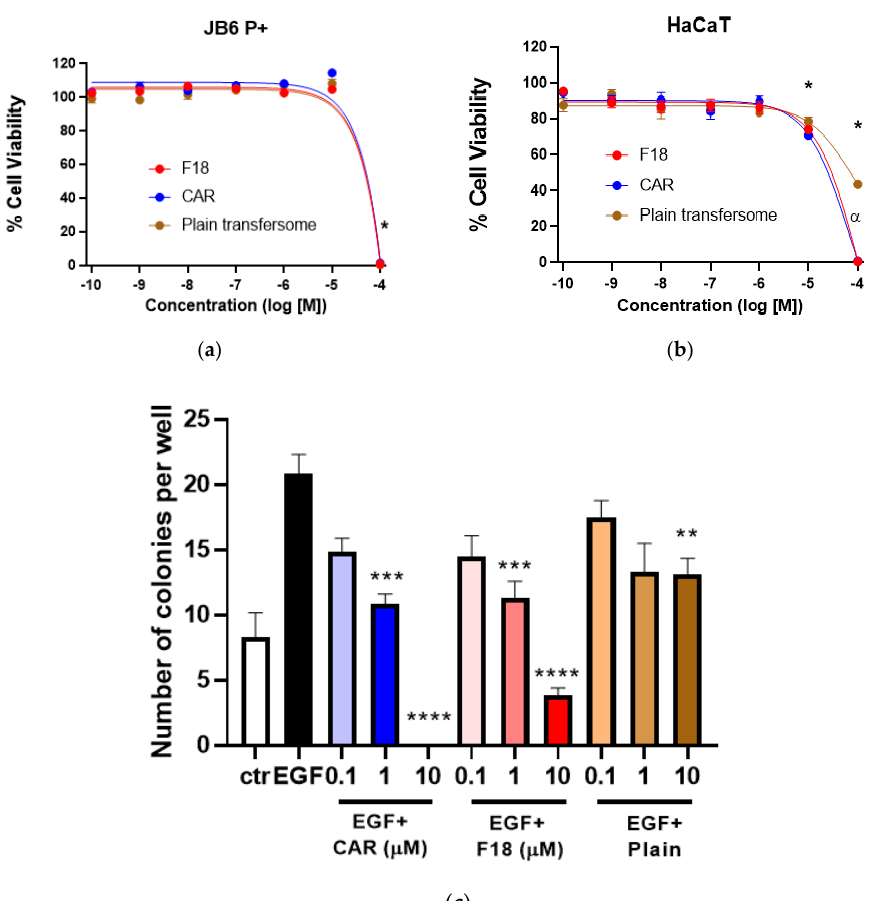
Figure 5. Effects of F18, free carvedilol, and the plain transfersome on cell viability of JB6 P+ and HaCaT cells and EGF-induced transformation of JB6 P+ cells. F18, free carvedilol, and the plain transfersome (with lipid concentrations equivalent to those in F18) were examined for their dose-dependent effects on the cytotoxicity (by SRB assay) on JB6 P+ ( a ) and HaCaT cells ( b ). Data were normalized to their respective controls. * p < 0.05 (2-factor ANOVA with Tukey Kramer post-hoc with an alpha set to 0.01). ( c ) Comparison of the effects of F18, free carvedilol, and the plain transfersome on the malignant transformation of JB6 P+ cells. The cancer preventive effects were examined using a soft agar assay. The data shown are the average numbers of colonies in each treatment group ( n = 8). (** p < 0.01, *** p < 0.001, **** p < 0.0001).